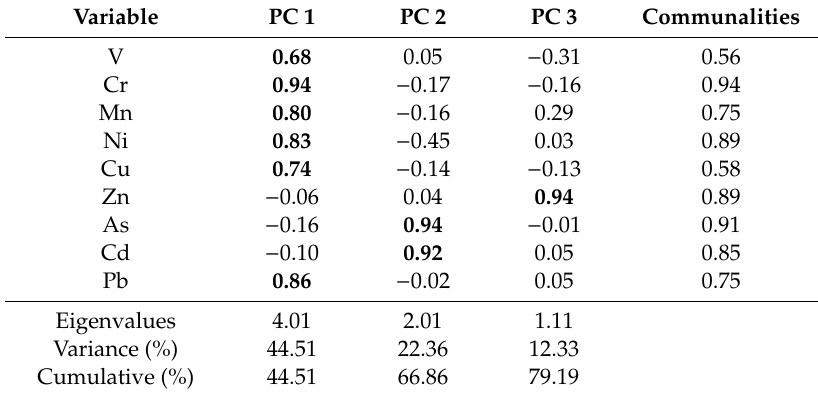
Table 6. Varimax rotated component matrix for heavy metal(loid)s of SPM in the Zhujiang River. Variable PC 1 PC 2 PC